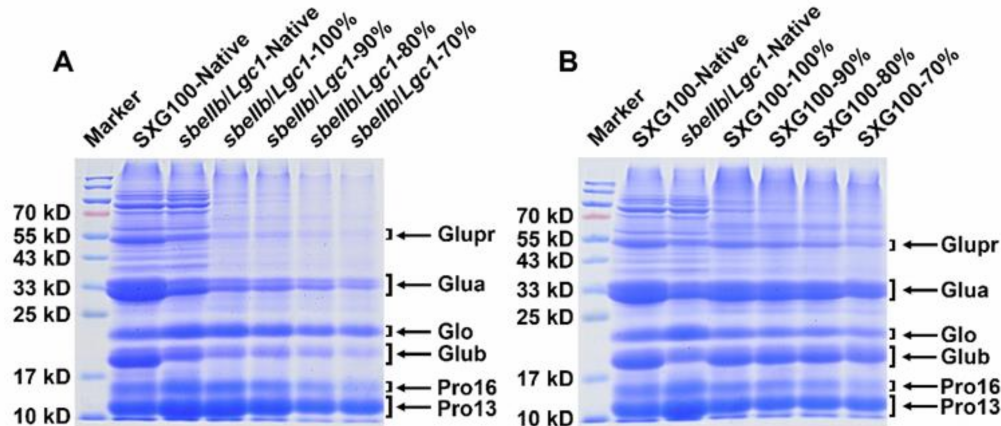
Figure 5. SDS-PAGE of total protein of the native and HMT flours of sbeIIb / Lgc1 ( A ) and SXG100 ( B ). Marker: protein molecular weight ladder; Glupr: glutelin precursor, Glua: glutelin acidic subunit; Glub: basic subunit, Glo: Globulin, Pro16: prolamin of ~16 kD, Pro13: prolamin of ~13